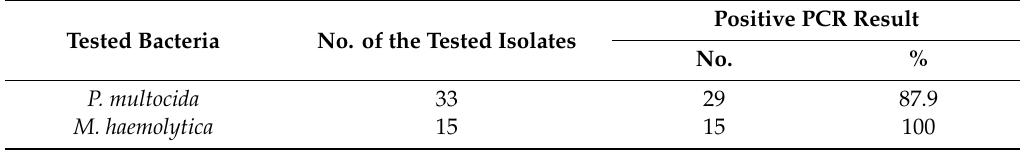
Positive PCR Result